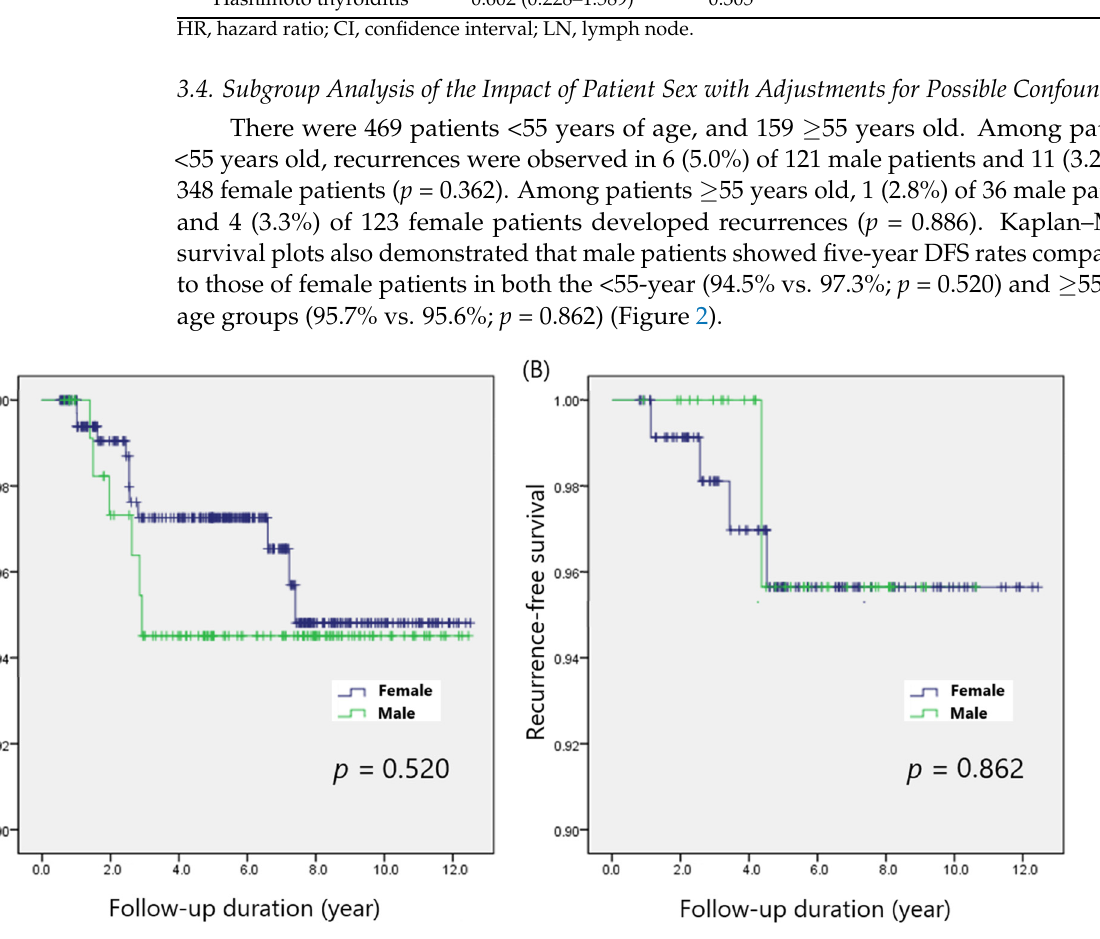
Figure 2. Disease-free survival in patients with ( A ) age <55 years and ( B ) age ≥ 55 years. Papillary thyroid microcarcinoma (PTMC; defined as PTC ≤ 1 cm) was found in 325 patients, and 303 patients had PTC > 1 cm (non-PTMC). The recurrence rates among male and female patients were 2 of 80 (2.5%) and 7 of 245 (2.9%; p = 0.866), respectively, in the PTMC group, and 5 of 77 (6.5%) and 8 of 226 (3.5%; p = 0.269), respectively, in the non-PTMC group. The five-year DFS was not significantly different between male and female patients in both the PTMC (97.4% vs. 96.8%; p = 0.618) and non-PTMC (91.9% vs. 97.0%; p = 0.243) groups (Figure